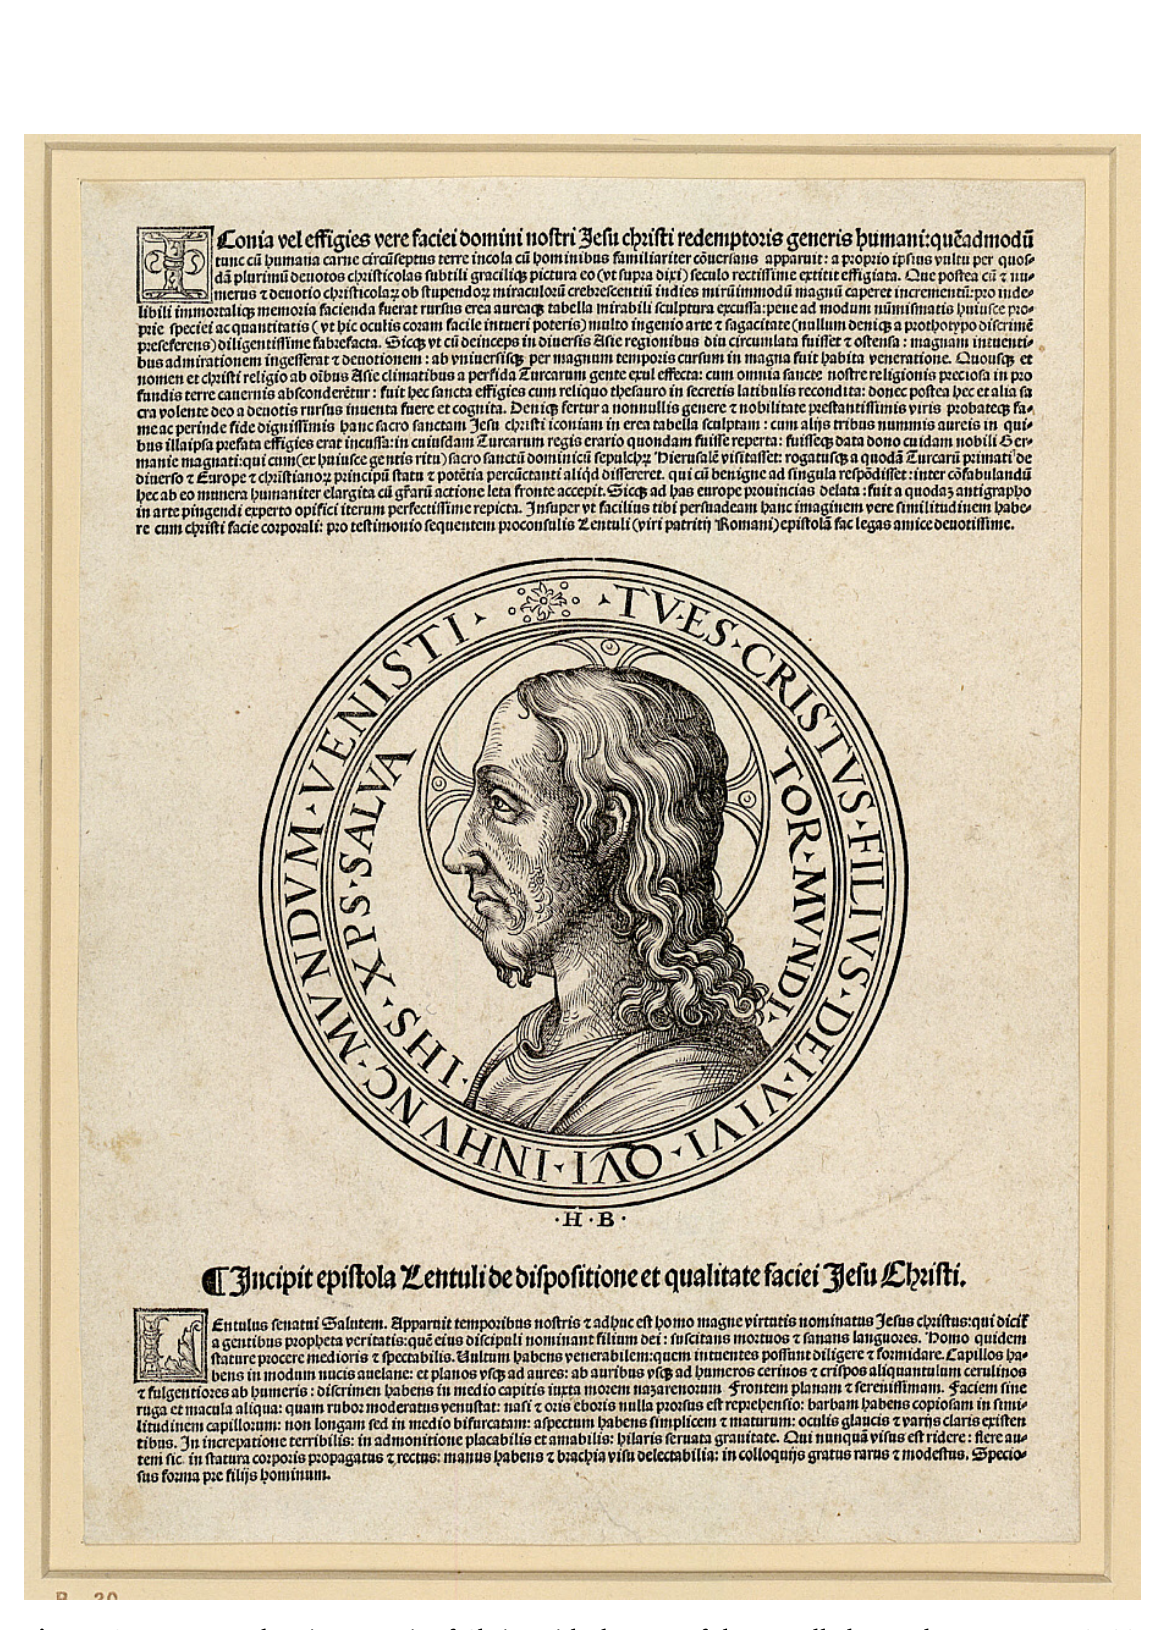
Figure 6 Hans Burgkmair, Portrait of Christ with the text of the so-called Lentulus Letter, ca. 1511, woodcut. The Albertina Museum, Vienna,